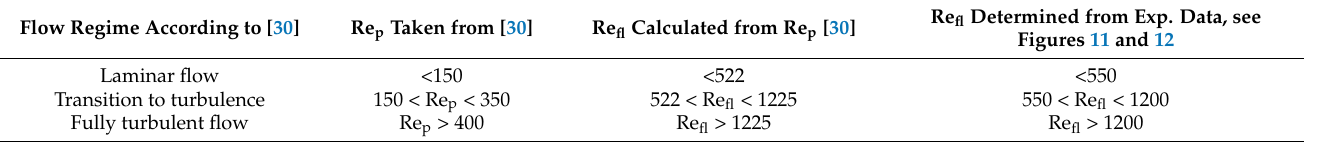
Table 6. Flow regime boundary for flow around single cylinder [30] compared with flow regime boundaries in flat tube with cylindrical pins determined from